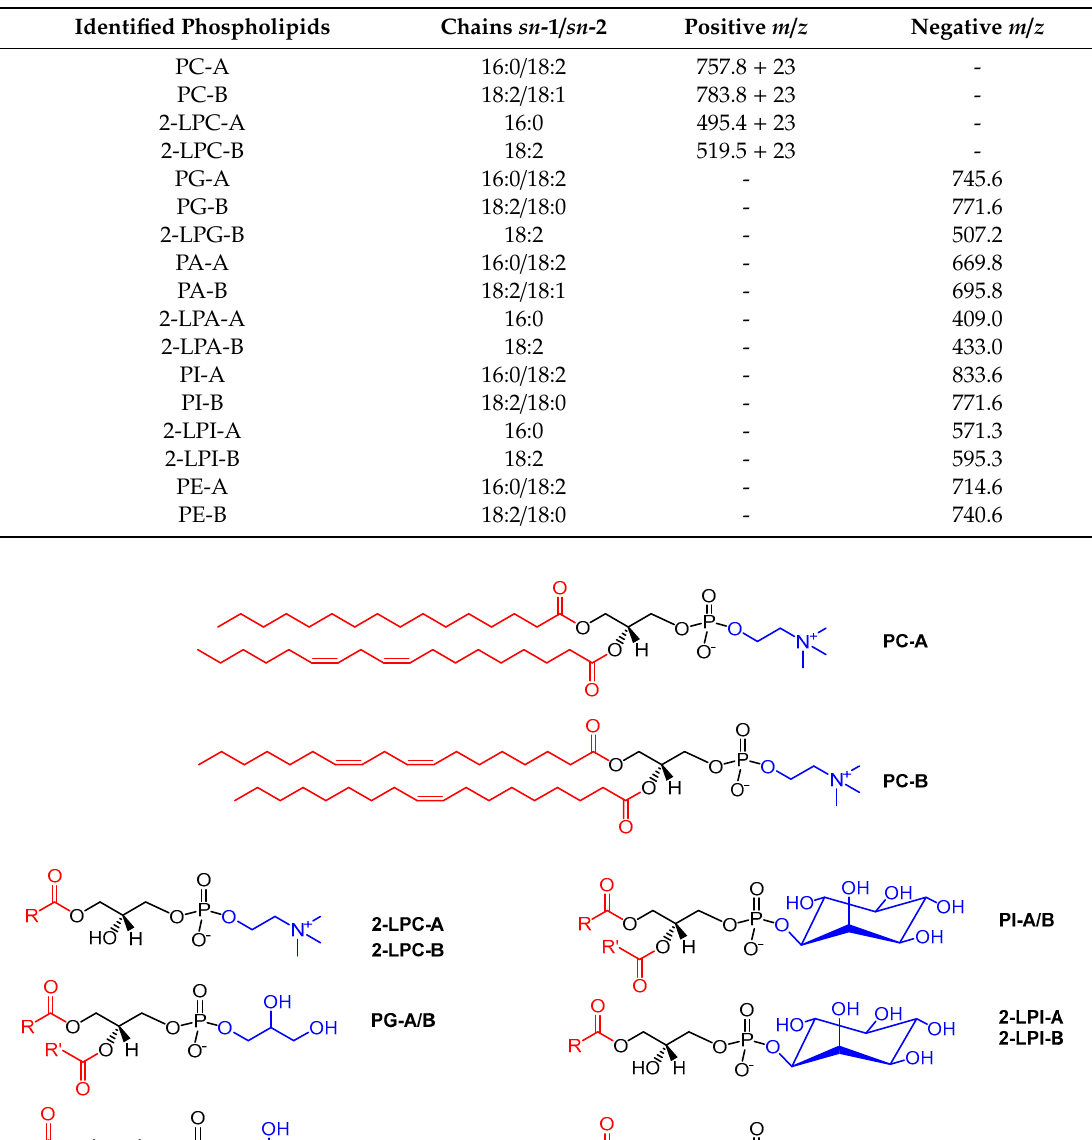
Table 2. Results of ESI / MS analysis of BF2-S fraction.